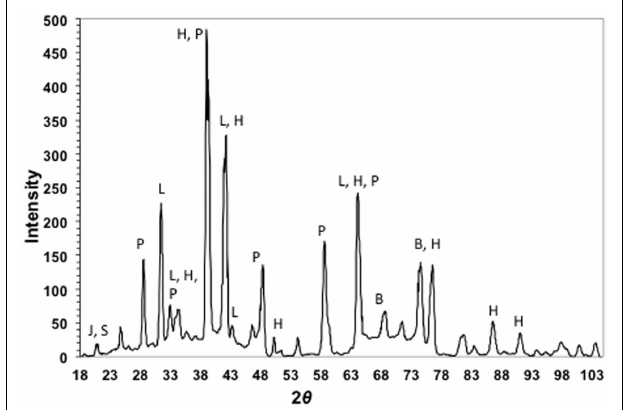
FIGURE 2 | Pore water metal(loid) concentrations for upper tidal slough sediment cores. Uncertainties are 2 SD.